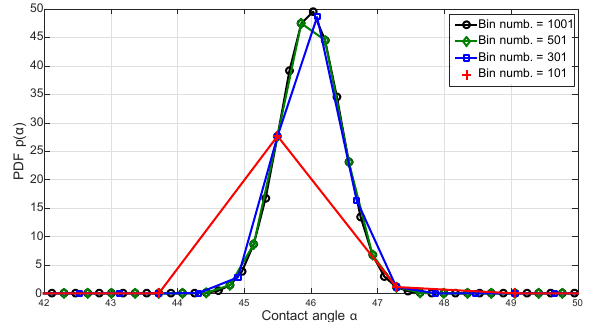
Figure 3. Probability p(α ) of the α -PDF model used for calculating the contact angle for immersion freezing. Different bin numbers are tested in order to correct the numerical formulation that is used in Wang et al.